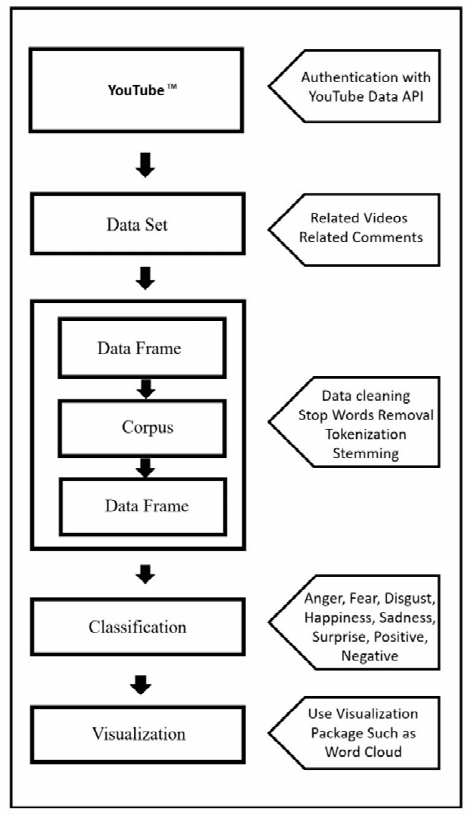
Figure 2. Workflow of sentiment–emotion analysis of the video comments.